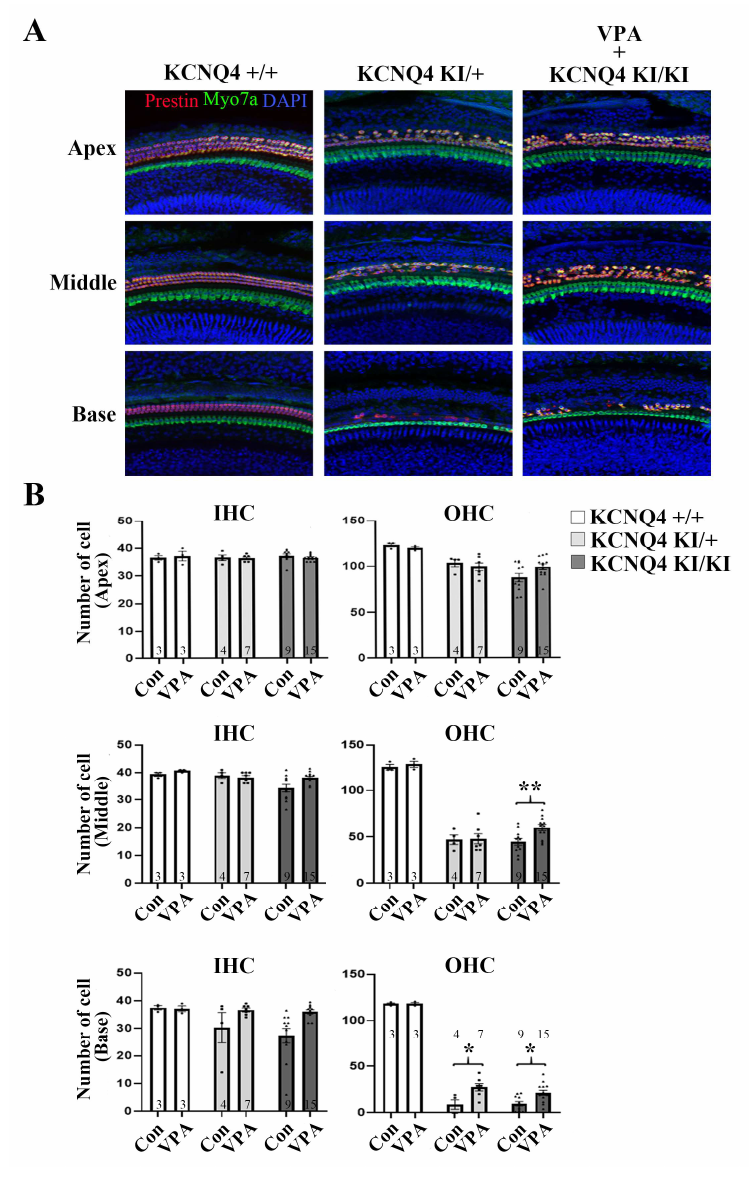
Figure 3. VPA protected-OHCs from cell death in the KCNQ4 p.W276S variant. ( A ) Representative image of mice cochlea immunostaining. Whole-mount immunostaining of the cochlea with